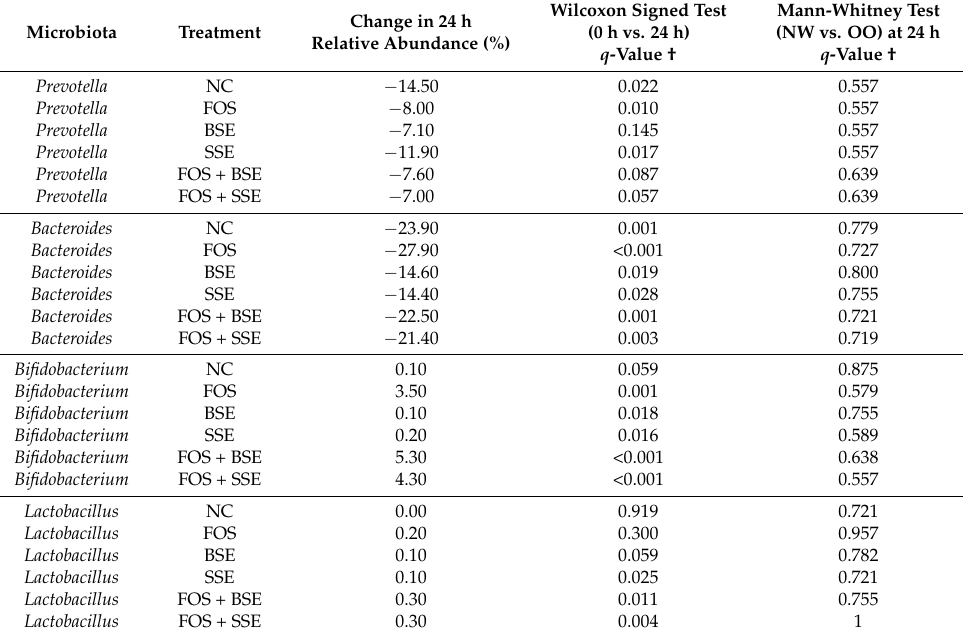
Table 4. The effects of time and weight class at the genus